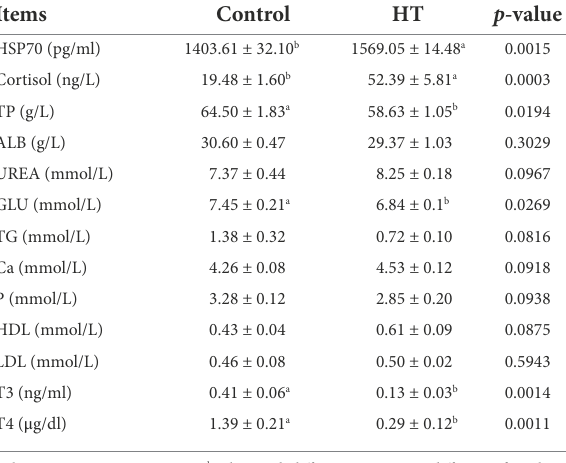
TABLE 2 Effects of Heat stress on serum biochemical of meat rabbits.